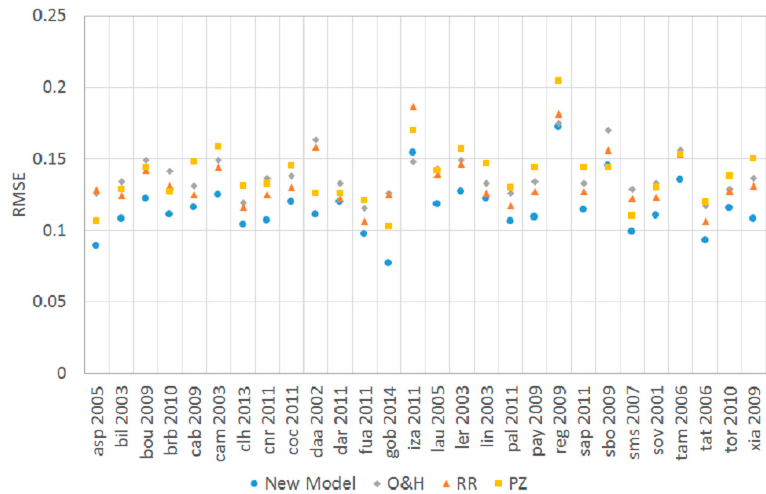
Figure 13. The root mean squared errors ( RMSE ) for all analysed datasets of the modelled versus the measured diffuse fraction. The RMSE of the new model is in all cases smaller than the RMSE of the model by Orgill and Hollands [18] (OH, grey), Reindl et al. [3] (RR, orange) or Perez and Ineichen [23] (PZ, yellow), except for the location of Izaña, Spain ( iza 2011 ), where the OH model produces a slightly smaller RMSE . The mean RMSE over all test cases is at 0.116 for the new model, 0.138 for OH, 0.134 for RR and 0.139 for PZ, which implies an amelioration of the RMSE of 16%–20%.